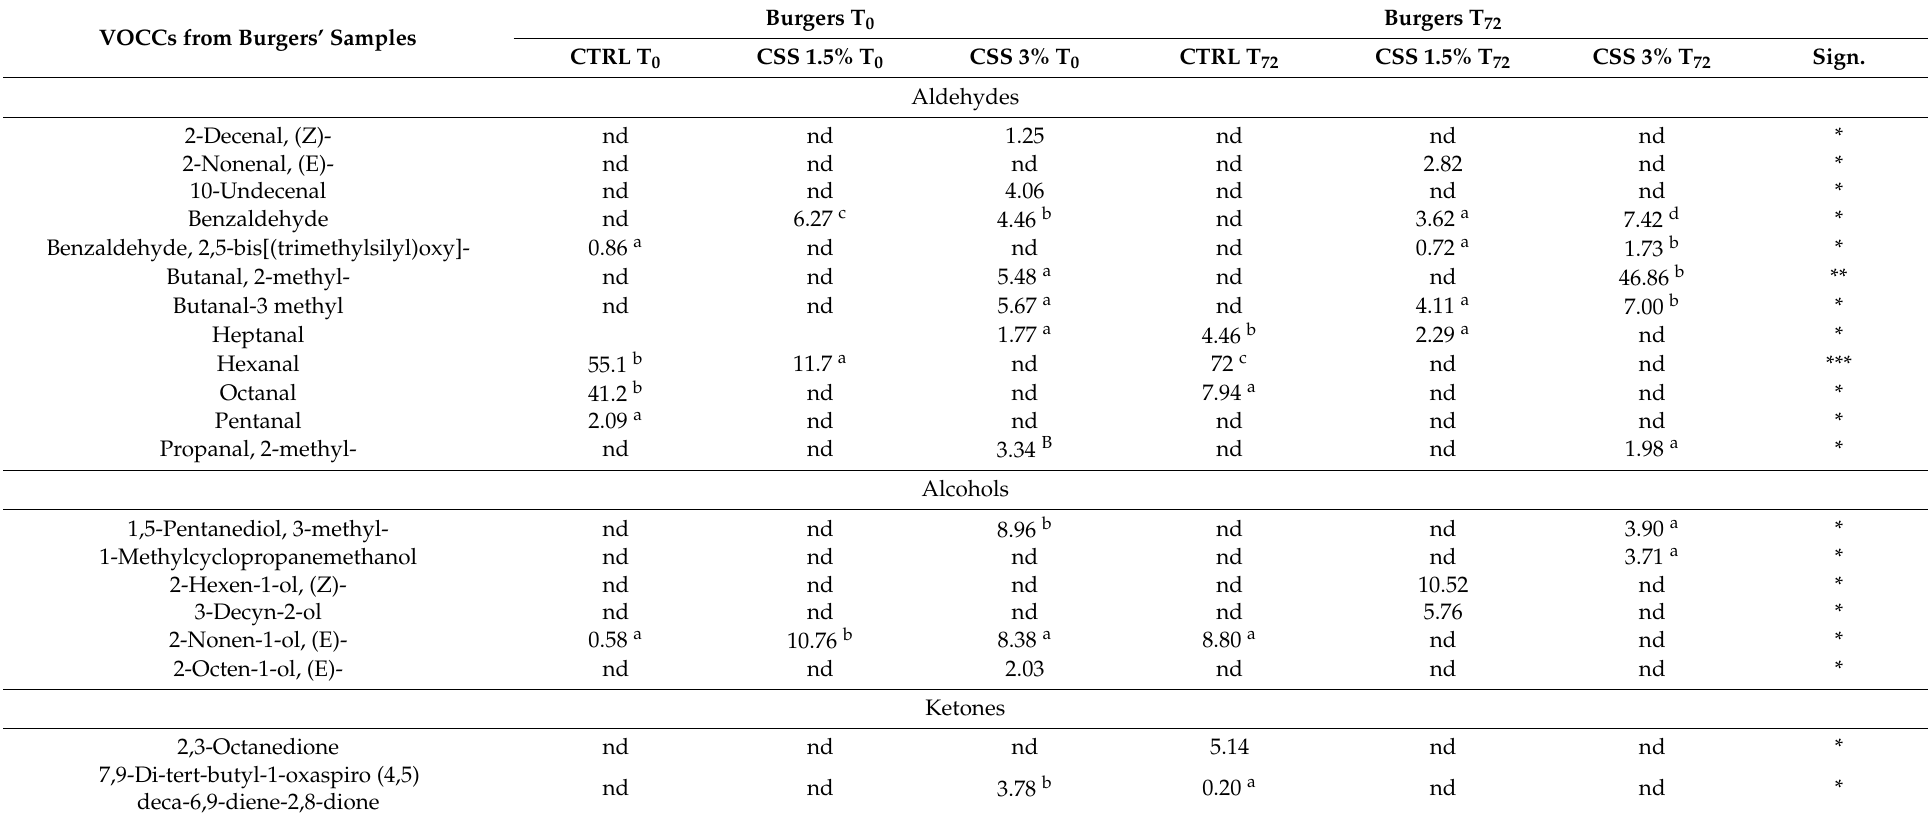
Table 4. Qualitative profile of main volatile compounds (area %) in cooked samples (control, addition of coffee silver skin 1.5 and 3%), immediately after cooking process (T 0 ) and after 72 h of storage at +4 ◦ C (T 72